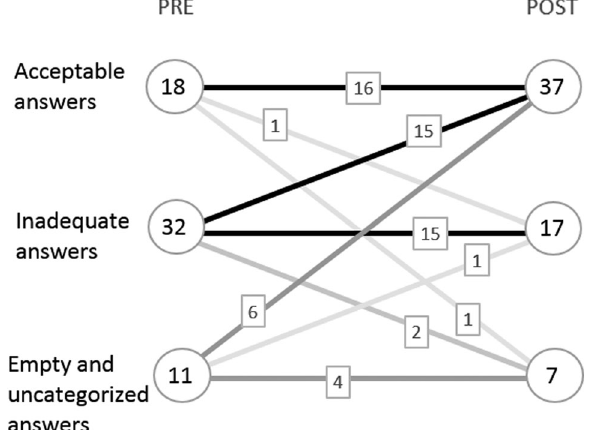
FIG. 2. The categorized responses of the whole cohort. The numbers within the circles show the numbers of students placed in the particular category in the pre- and post-testing phases. The numbers within the rectangles indicate the frequencies of transfers between the pre- and post tests N ¼ 61